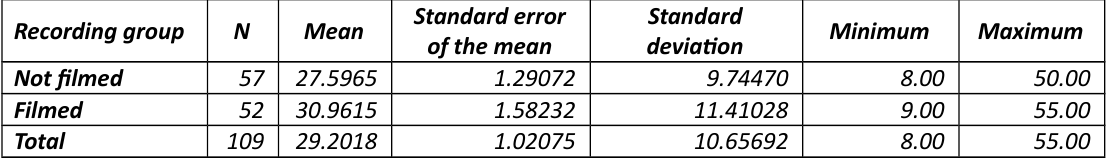
Table 2. Results of the State inventory